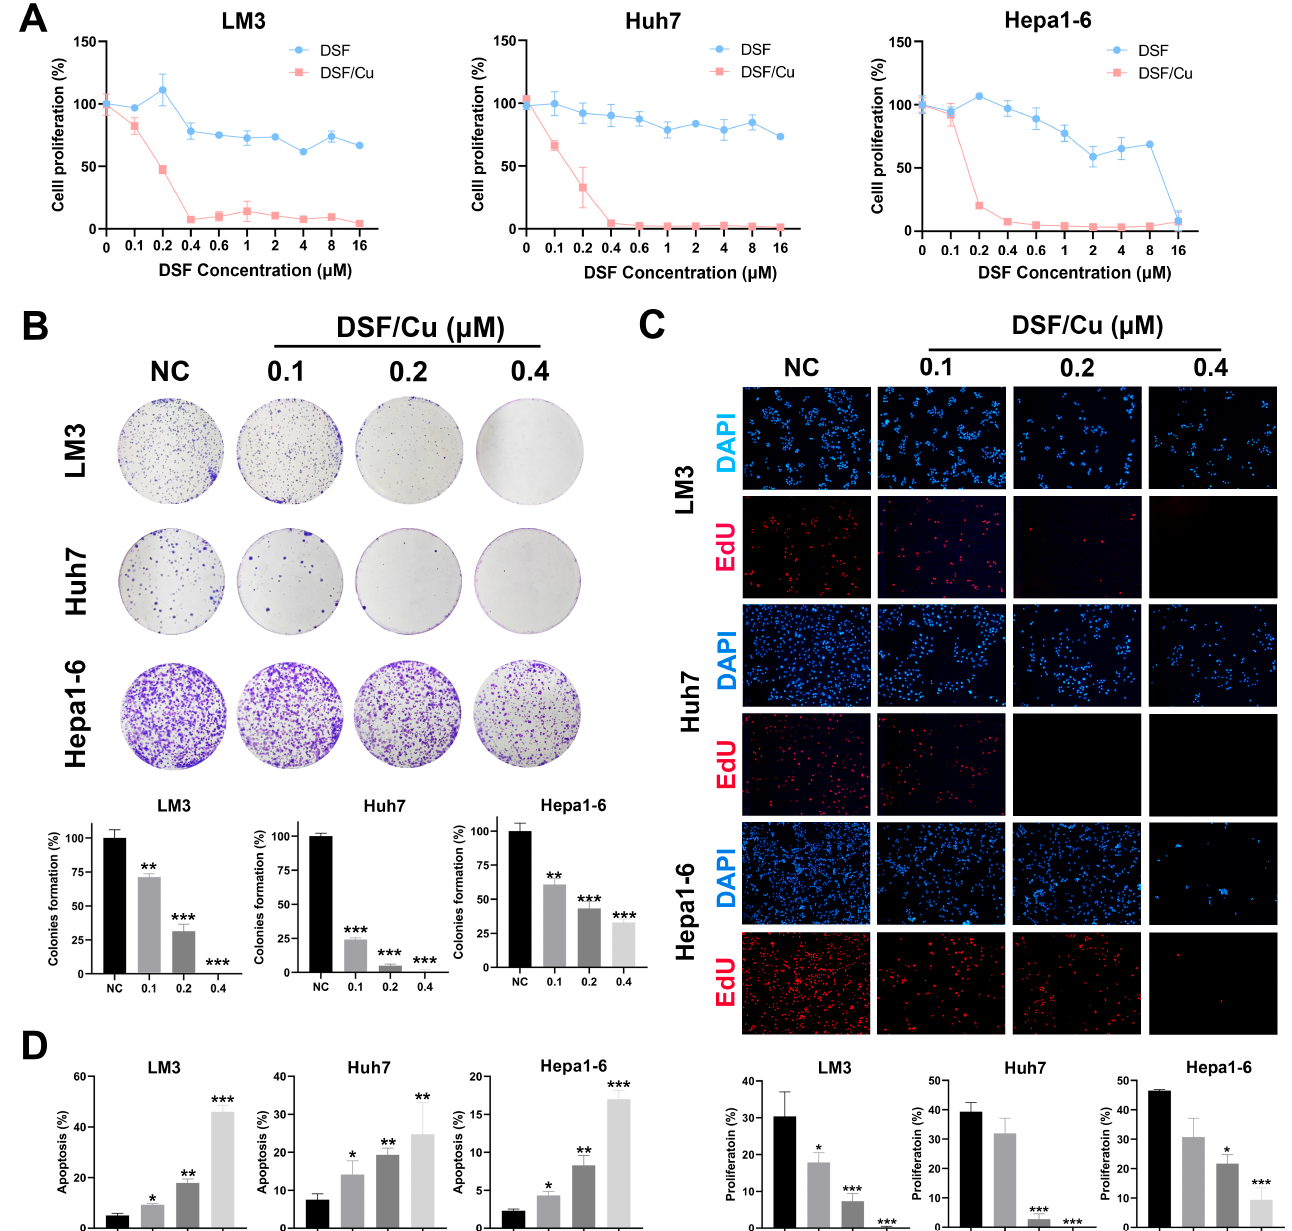
Figure 1. DSF/Cu inhibits proliferation and induces cell death in HCC cells . ( A ) Cell viability of LM3, Huh7, and Hepa1–6 treated with DSF/Cu at indicated concentration for 24 h. ( B ) The colony formation of LM3, Huh7, and Hepa1–6 cells under the treatment of DSF/Cu at indicated concentration. ( C ) The proliferation of LM3, Huh7, and Hepa1–6 HCC cells treated with DSF/Cu at indicated concentration were detected by Edu assay. Images with magnification at 100 × are shown here. ( D ) Apoptosis analysis of LM3, Huh7, and Hepa1–6 cells treated with indicated concentration of DSF/Cu. *, p < 0.05; **, p < 0.01; ***, p < 0.001 .